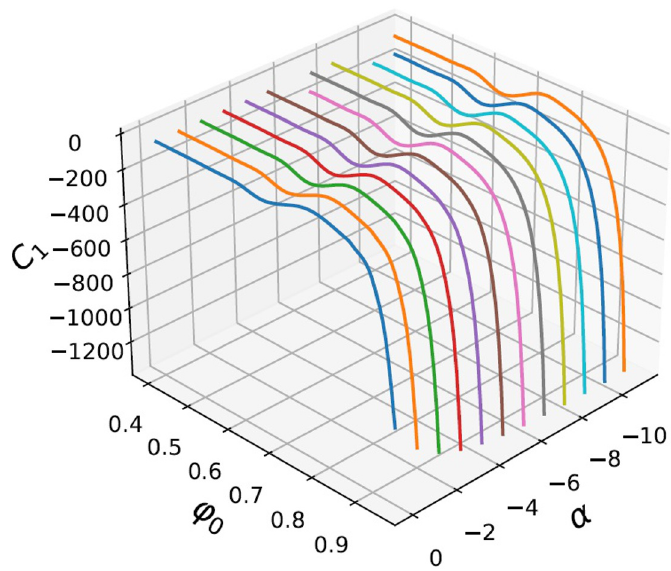
Figure 12 . The integration constant C 1 as a function of the two parameters, ϕ 0 and α , for Nut end-point solutions.